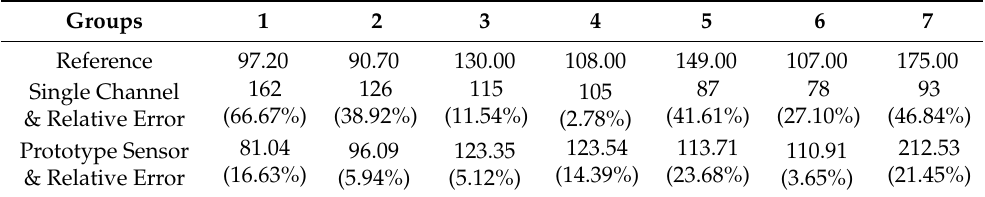
Table 4. Data of the mass concentration of DEHS samples obtained by our prototype sensor versus the reference